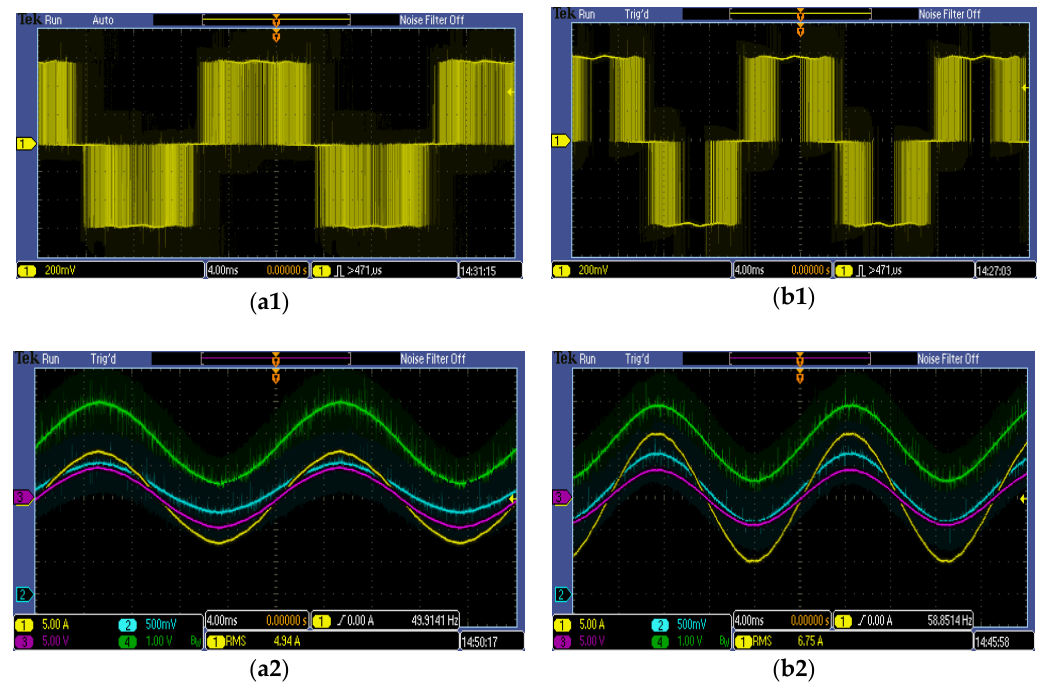
Figure 10. Results for the 2 kW AC motor speed control application using the FDRM-KL25Z DSP card; ( a1 , b1 ) motor frequency response to sudden increase/decrease of electric load; ( a2 , b2 ) voltage (green) and current (blue) response to sudden increase/decrease of the load (reference signal of microcontroller in pink and load current in yellow).